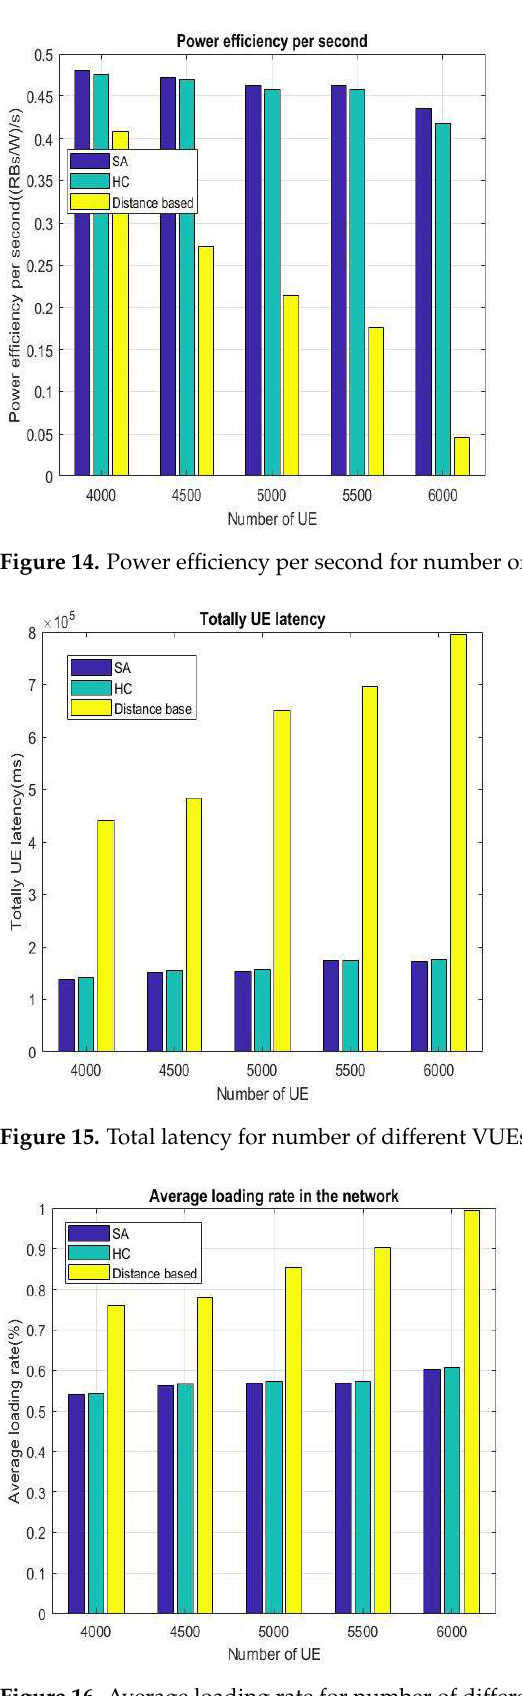
Figure 16. Average loading rate for number of different